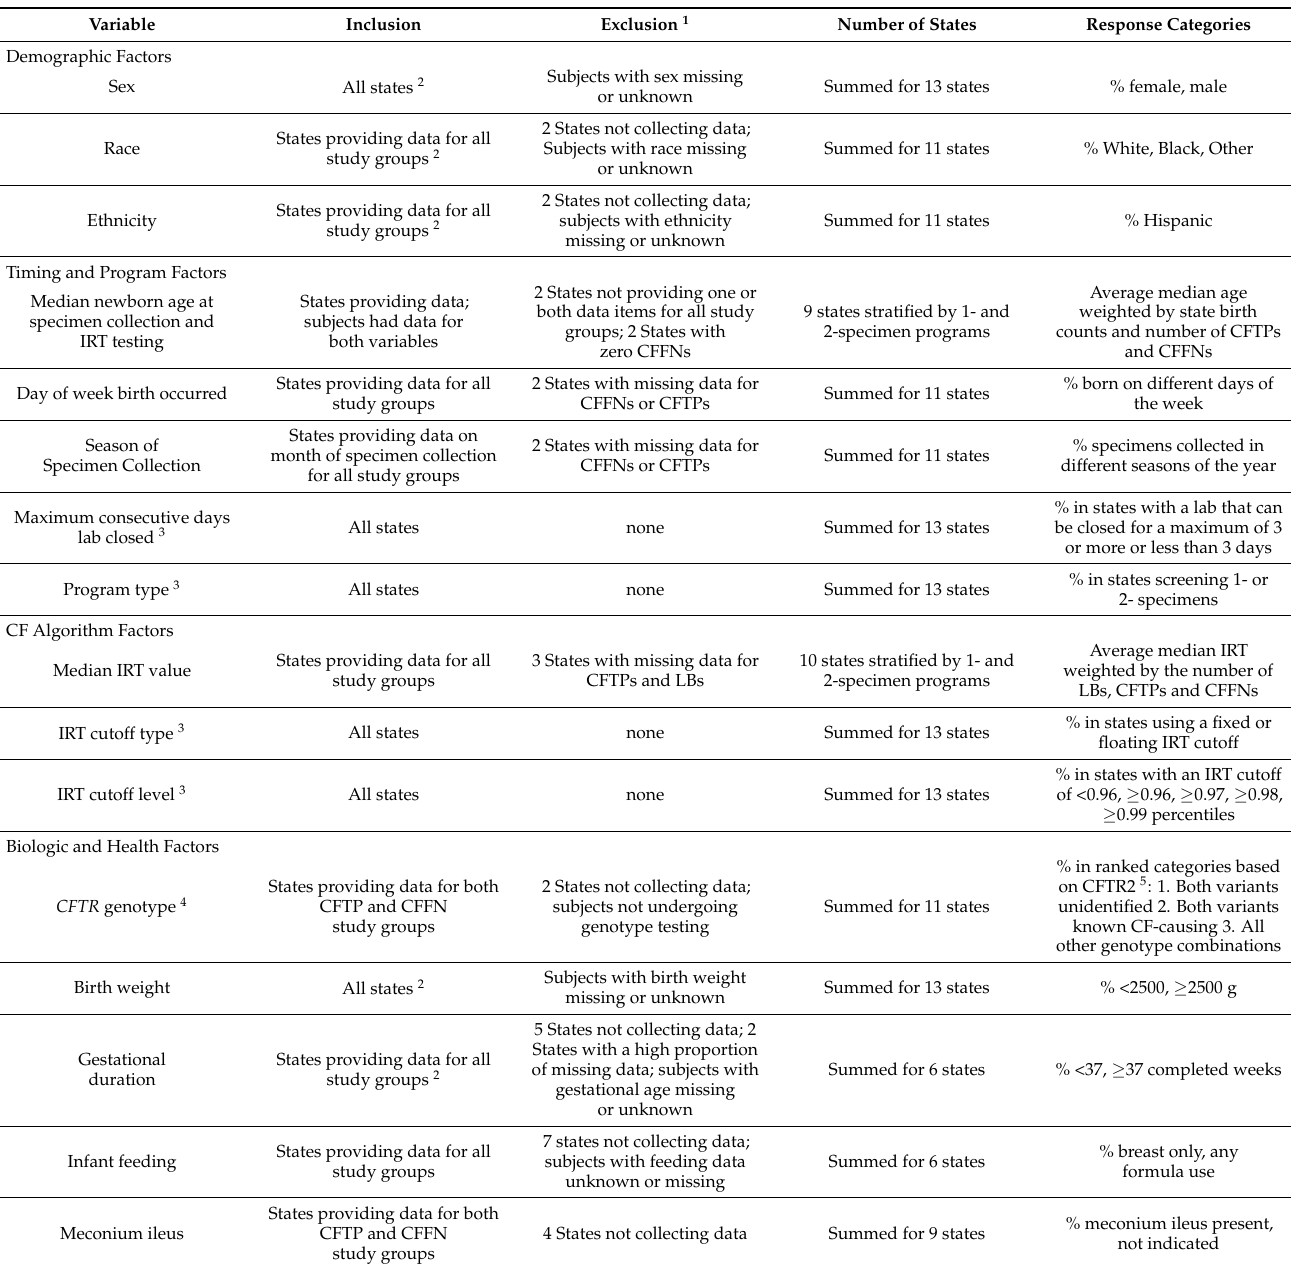
Table 1. Study variables by inclusion and exclusion criteria, number of states and response categories used in main